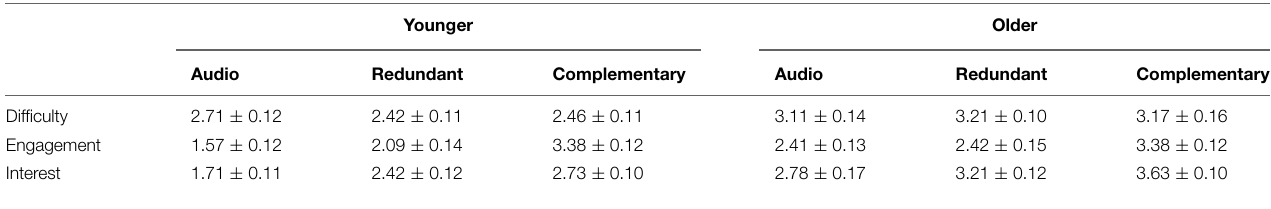
TABLE 2 | Mean ratings of perceived presentation material difficulty, engagement, and interest for both age groups ( ±